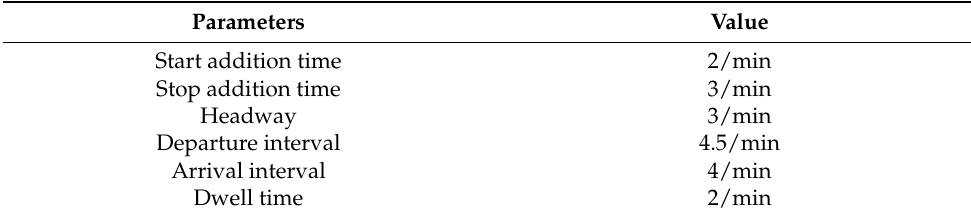
Table 6. The safety operation parameters.